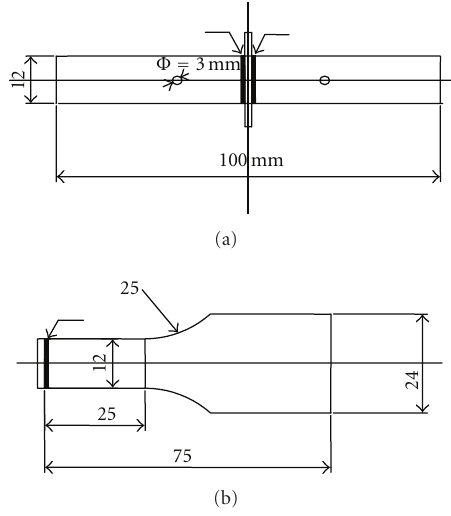
Figure 2: Specimen geometry for T-pull test.